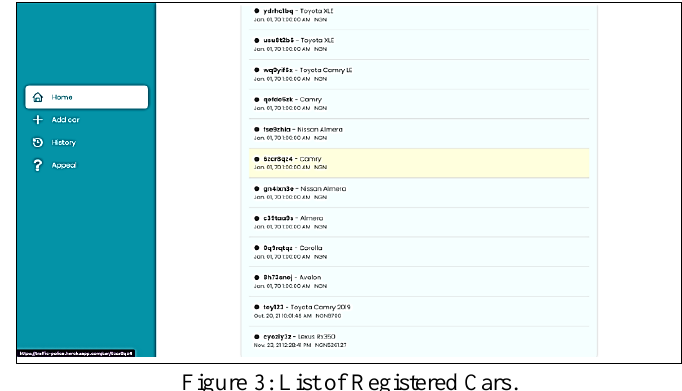
Figure 3: List of Registered Cars.